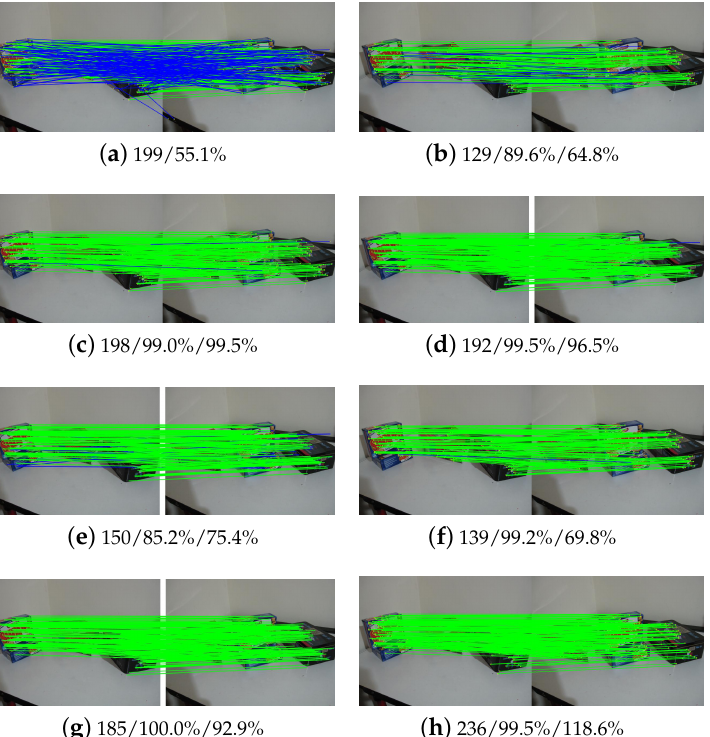
Figure 20. Matching results of image pair 5 in the non-rigid dataset: ( a ) initial matches; ( b )